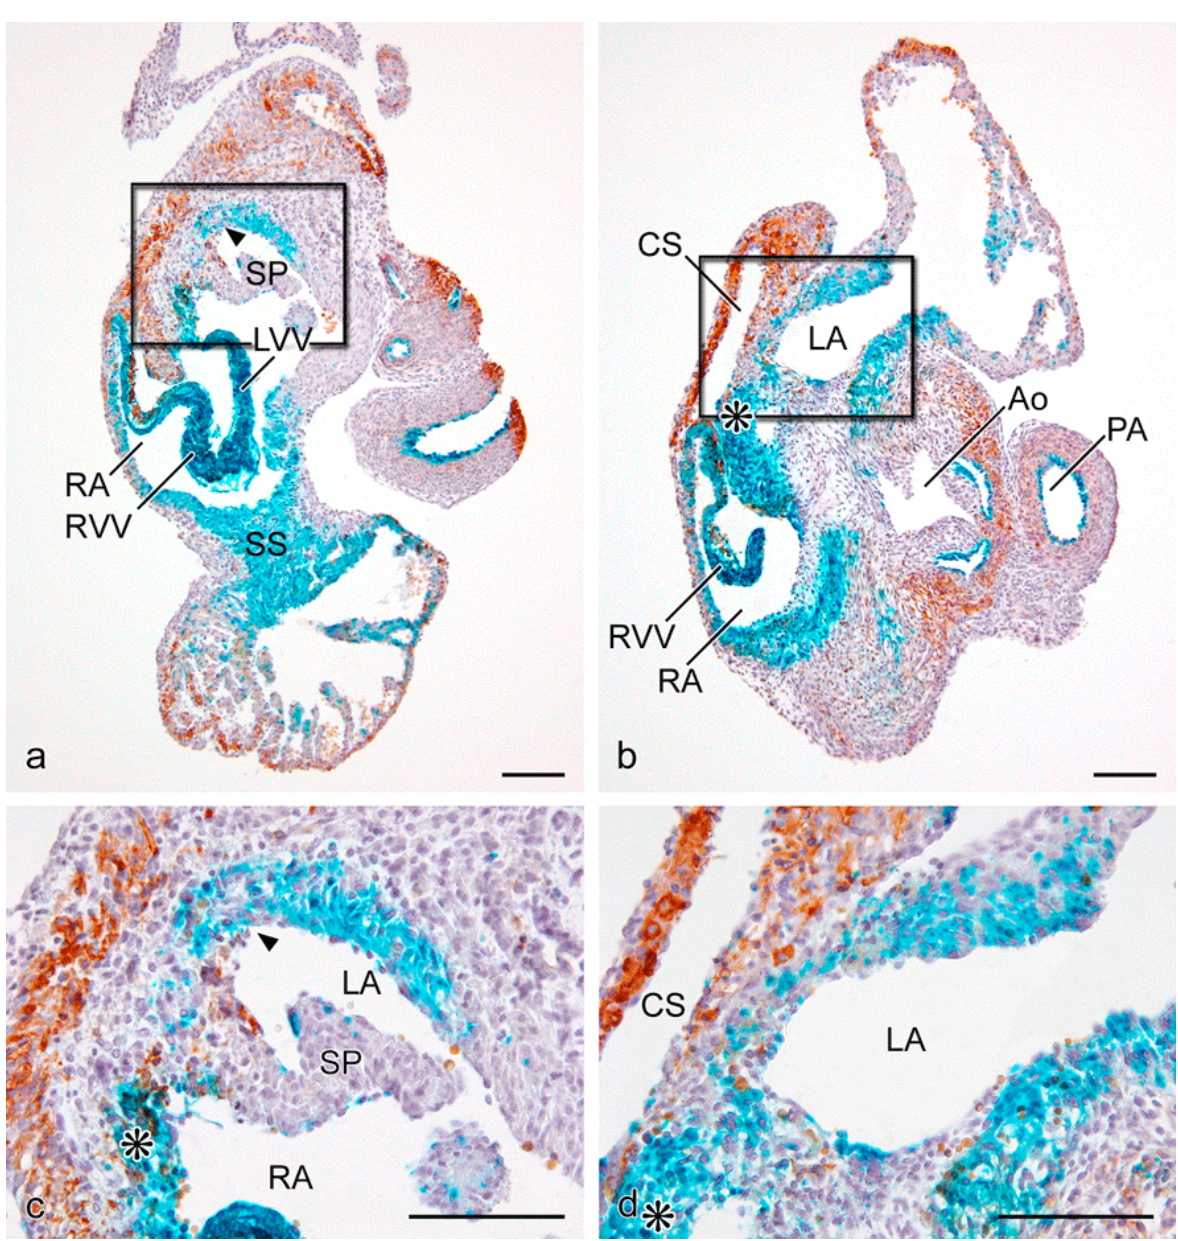
FIGURE 7. Transversal sections at the atrial level of a CCS- lacZ mouse at age E14.5. a,b: Sections at the level of entrance of the pulmonary vein (arrow head) in the left atrium (a) and through the coronary sinus (b). CCS- lacZ expression is observed in the right venous valve (RVV), left venous valve (LVV), and septum spurium (SS) of the sinus venosus. c,d: Details of the boxed areas in a and b that demonstrate continuity of the CCS- lacZ –positive myocardium of the left atrial dorsal wall with the base of left venous valve of the sinus venosus (asterisk) in the right atrium. Ao: aorta, CS: coronary sinus, LA: left atrium, PA: pulmonary artery, RA: right atrium, SP: septum primum. Adapted from Jongbloed et al.[104]. Scale bars:100 μ